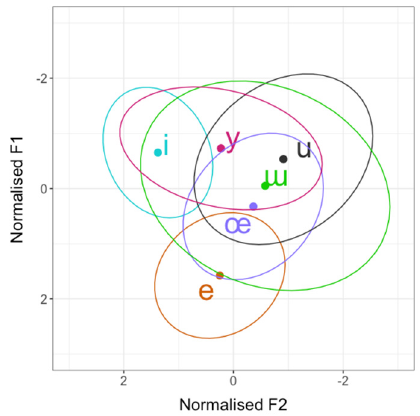
Figure 4. Normalised mean F1 and F2 values for L2 Turkish vowels for all speakers combined. Each ellipse includes approximately 95% of the samples in each vowel